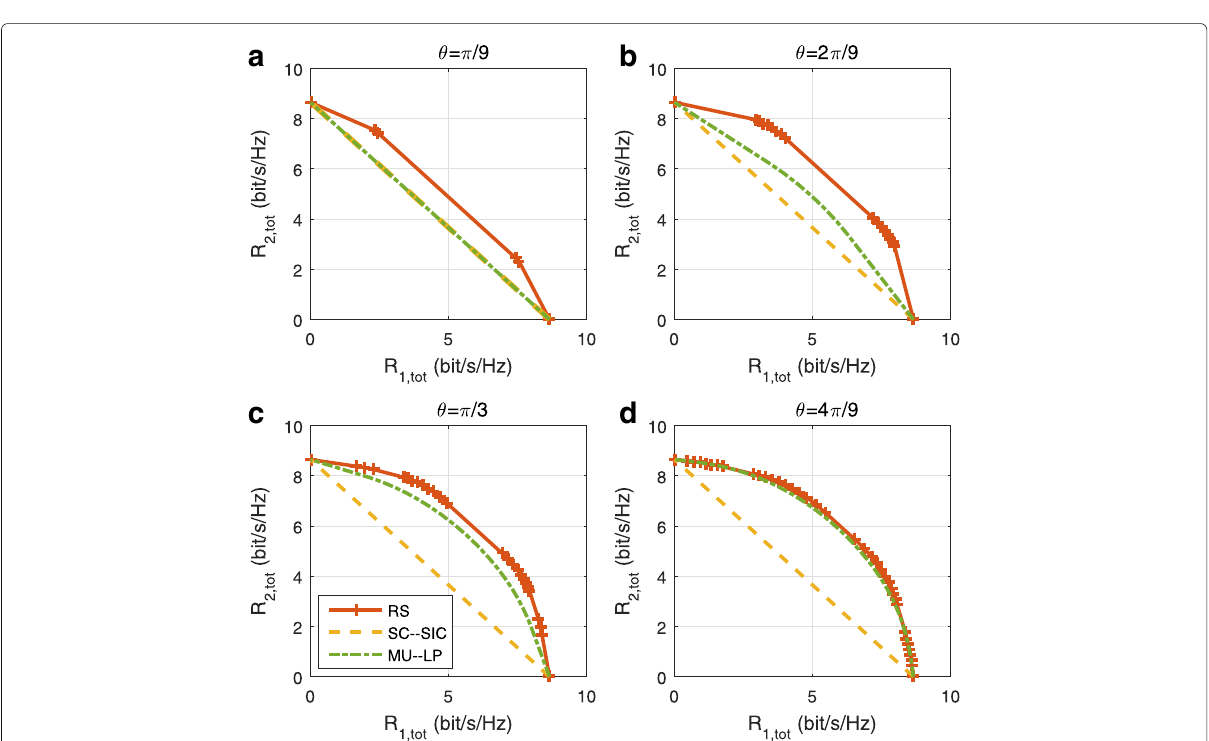
Fig. 11 Average rate region comparison of different strategies in imperfect CSIT, γ = 1, N t = 4, SNR = 20 dB. a θ = π/ 9. b θ = 2 π/ 9. c θ = π/ 3. d θ = 4 π/